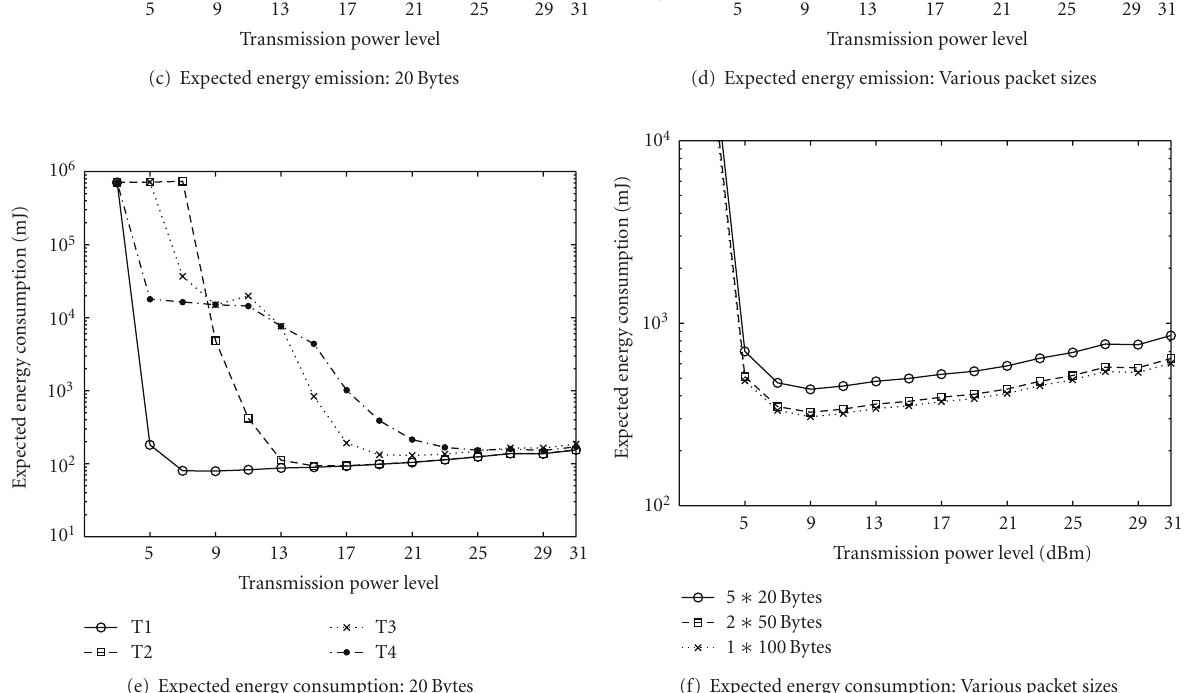
Figure 3: The PDR-table and expected energy emission and consumption for IEEE